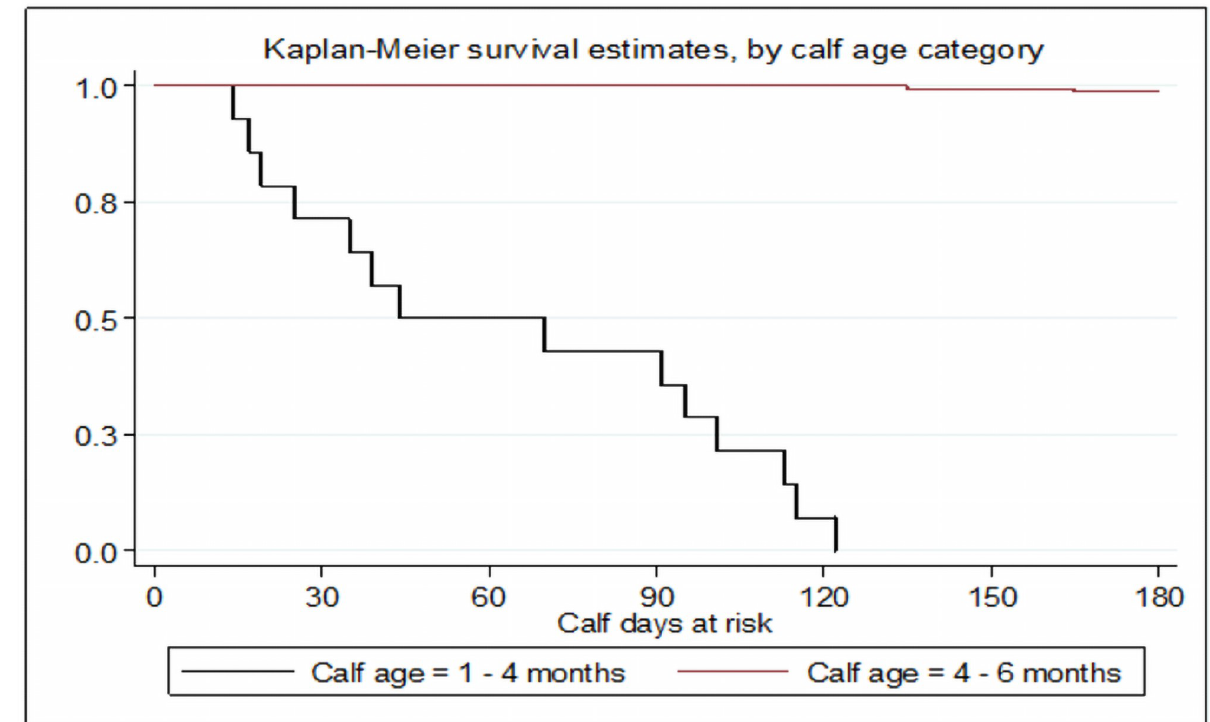
Fig 3. Description of the median survival age of mortality by age category in months.